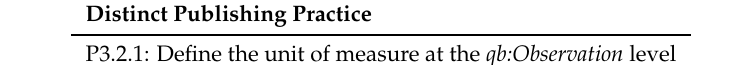
Table 31. Single practice of data portals regarding the structural definition of the unit of